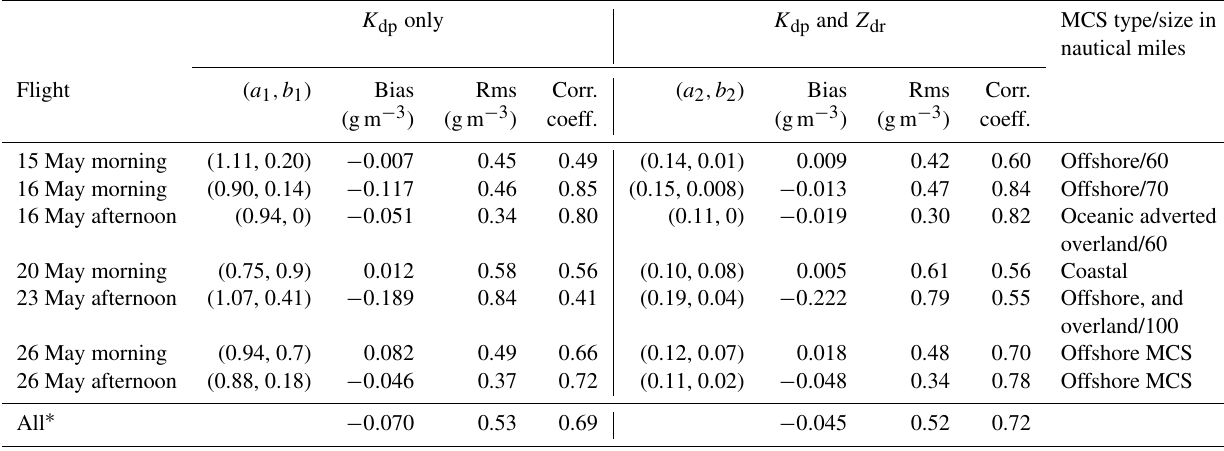
Table 2. Polarimetric method performance for selected flights during the Cayenne 2015 campaign. The MCS types and scales from Strapp et al. (2016) are also listed.